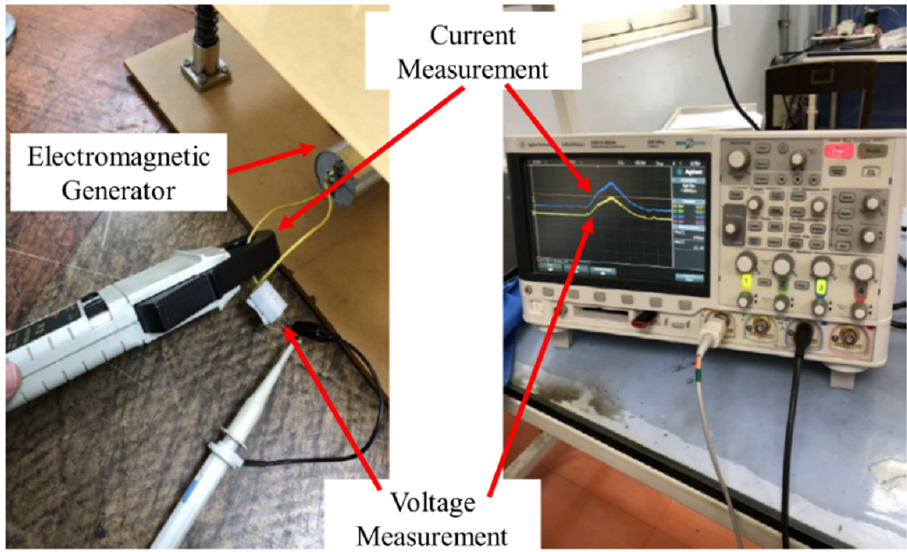
Figure 10. The measurement of the voltage across the load resistor and the Figure 10 . The measurement of the voltage across the load resistor and the current.